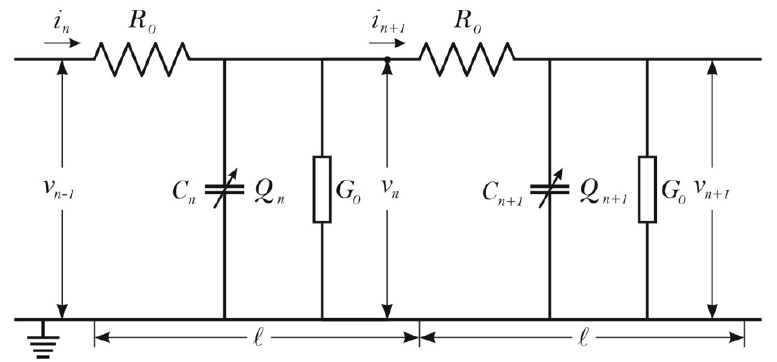
Figure 3. An effective circuit diagram for the n-th unit with characteristic elements for Kirchhoff’s laws applied to a microtubule as an ionic cable [61].